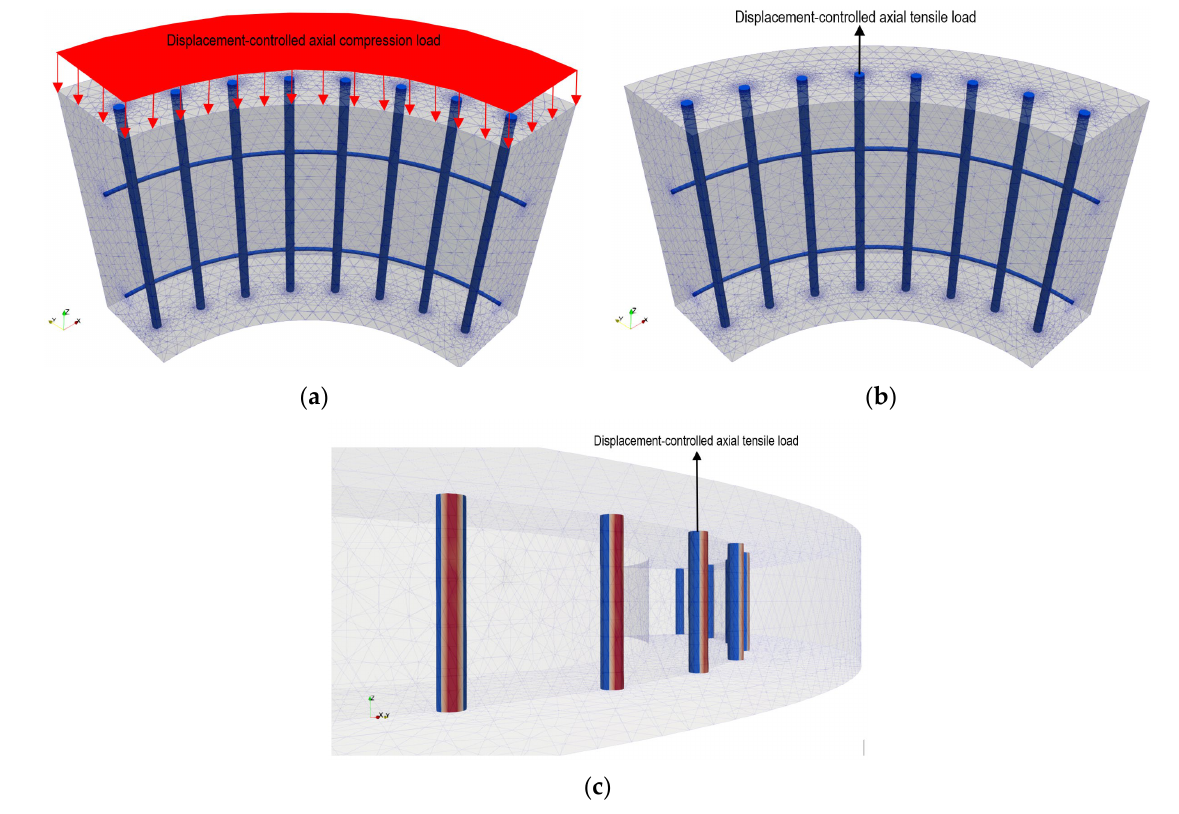
Figure 5. Three kinds of analyses considered in this study: ( a ) Case 1; ( b ) Case 2; ( c ) Case